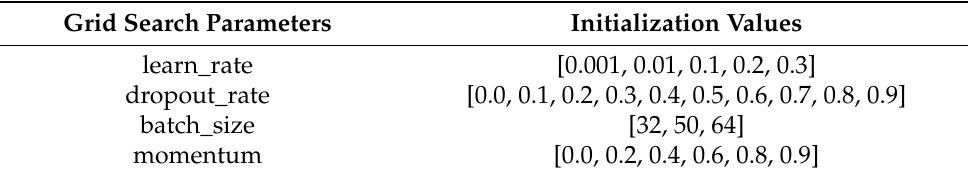
Table 2. Grid search space